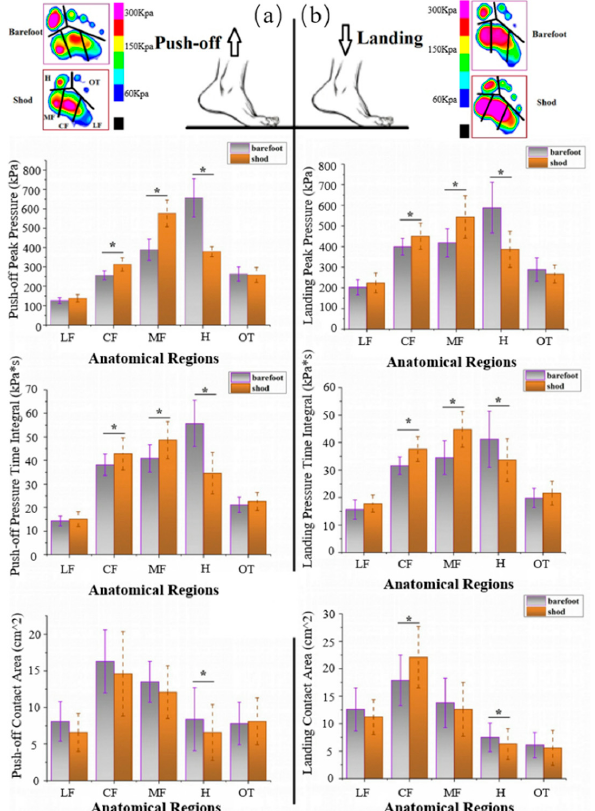
Figure 1. The peak pressure, pressure time integral, and contact area in the anatomical regions during the push-off ( a ) and landing ( b ) phases of the vertical jump. lateral forefoot (LF), central forefoot (CF), medial forefoot (MF), hallux (H), and other toes (OT). * indicates significance between variables, p < 0.05.